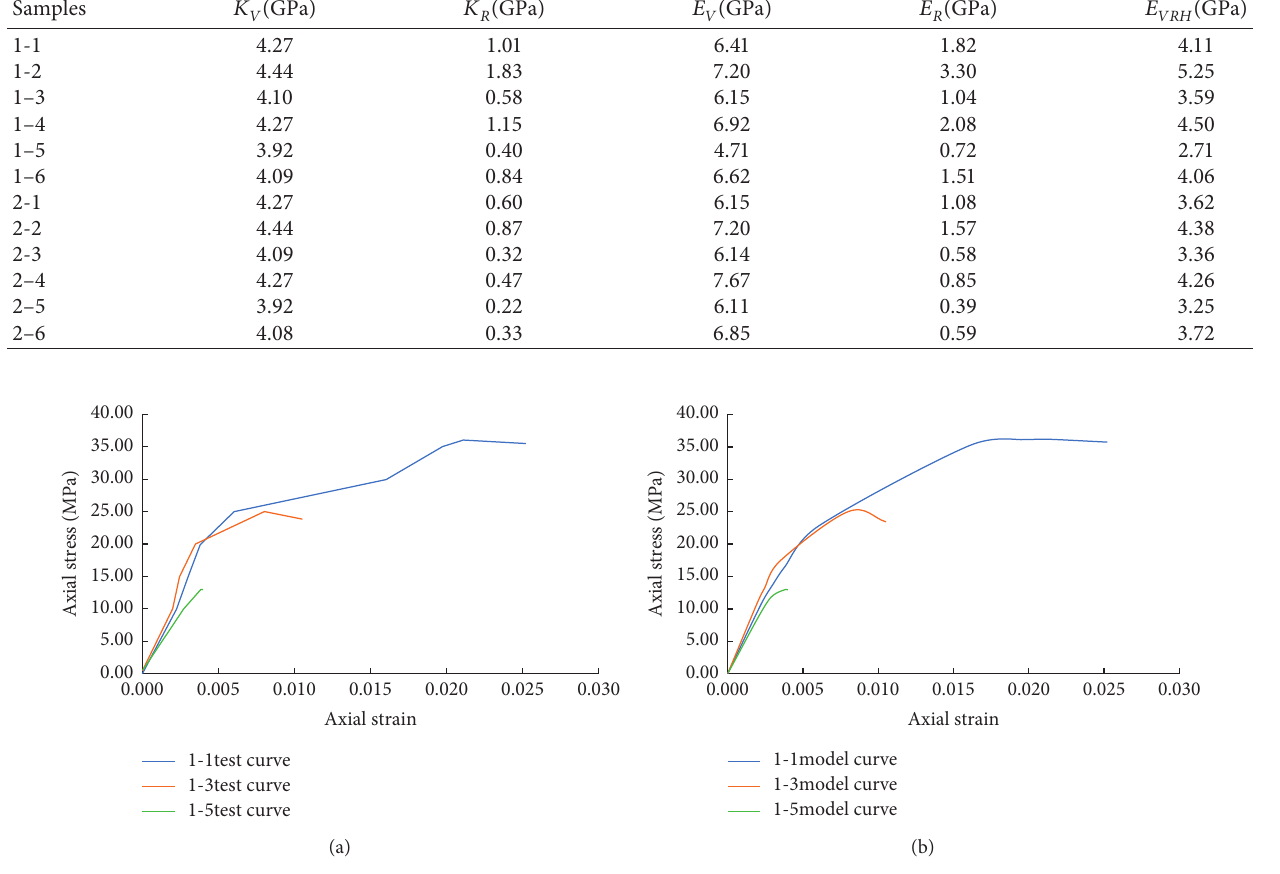
Figure 2: Test stress-strain curve((I) of filled cracked rocks with gypsum mortar ( σ